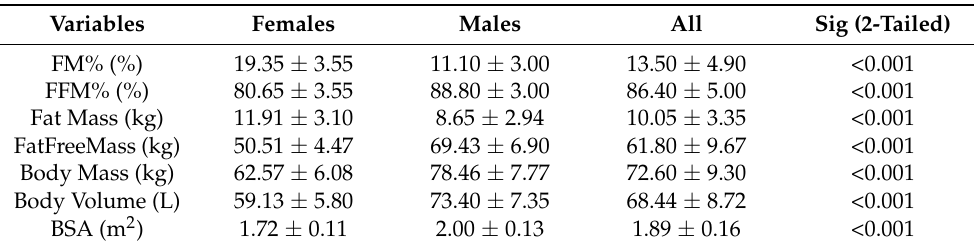
Table 3. Common indicators of body composition: summary statistics (median ± MAD) and Mann– Whitney